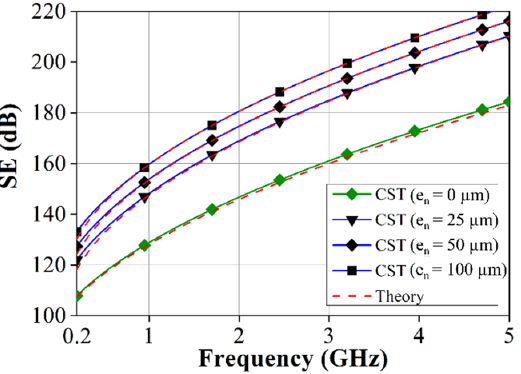
Figure 5. SE comparison between a 12 µm Cu single layer (0 µm spacing) and two 6 µm Cu layers with a different spacing.